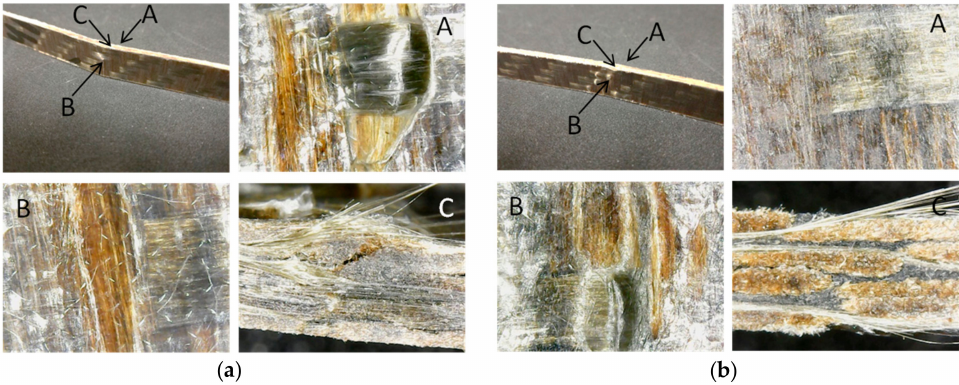
Figure 8. Optical micrographs showing the composite samples based on the not plasticizes PA11 TL ( a ) and plasticized PA11 P40 ( b ) after the Charpy-like tests. For both figures, the sub figures A, B and C represent the top view, the bottom view and the side view,